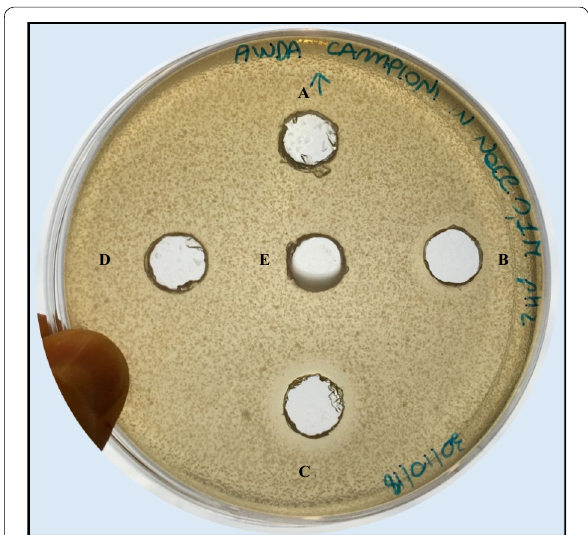
Fig. 3 Effect of proteinase K on the purified bacteriocin-like compound. The antimicrobial activity of the purified bacteriocin-like compound was determined as halo of growth inhibition of E. coli ATCC 25922 through the agar well diffusion assay. The Figure shows the lack of inhibition zone produced by the treatment of the bacteriocin-like compound by proteinase K (A); the inhibition halo produced by the no-treated bacteriocin-like compound after incubation at 37 °C and pH 7.5 (the proteinase K optimal pH) (B); the inhibition zone produced by the untreated bacteriocin-like compound at pH 2 (its optimal pH), as a positive control of the test (C); the lack of inhibition halo produced by the negative control NaCl 0.1 M pH 7.5 (buffer of the reaction with proteinase K) (D); and the lack of inhibition halo produced by the negative control NaCl 0.1M pH 2 (buffer for bacteriocin-like molecule activity)